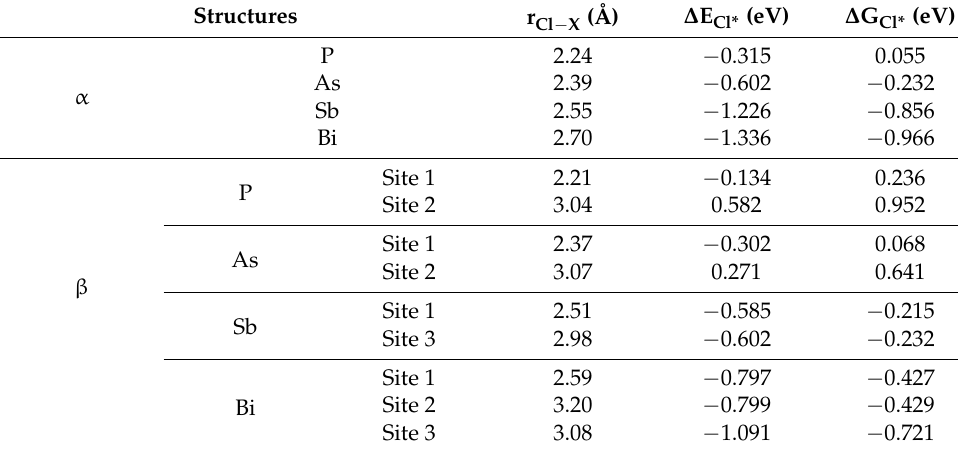
Table 2. Calculated average distance between Cl and group-VA atoms (r Cl − X ), adsorption energy ( ∆ E Cl* ), and Gibbs free energy change ( ∆ G Cl* ) on different sites of group-VA 2D monolayers with α and β